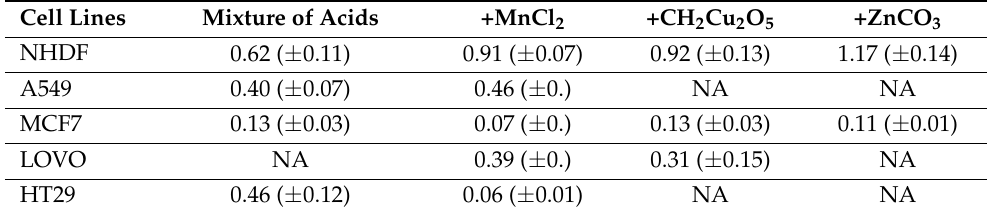
Table 16. IC 50 values against normal and tumour lines incubated for 48 h with garlic essential oil ( Allium sativum L.) and the components used in the study.